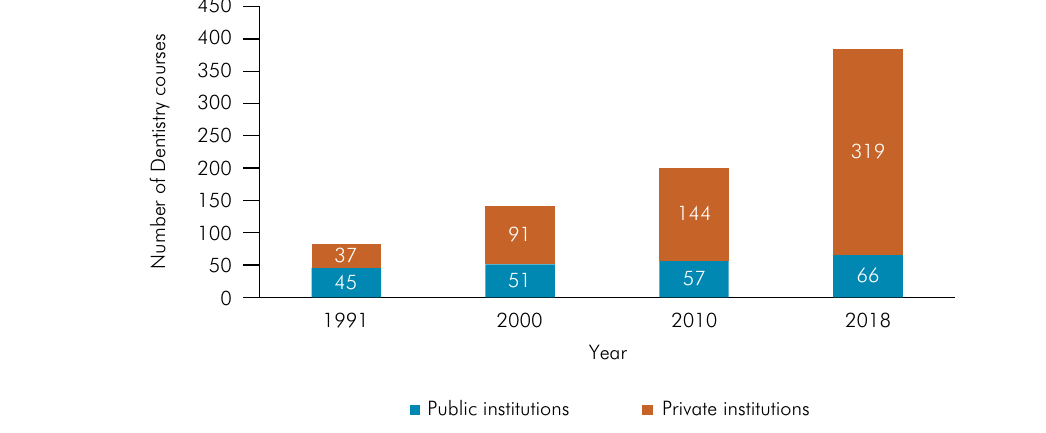
Figure 2. Juridical nature of Dentistry courses in Brazil from 1991 (n = 82) to 2018 (n = 385), obtained from CES. 11